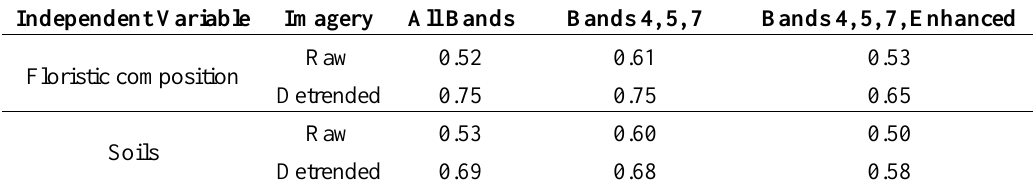
Table 3. Relationship between Landsat data, and either floristic or soils data, for Pastaza-Tigre sites. Values are the coefficient of determination (r 2 ) for linear regressions between the floristic gradient (measured by a single NMDS axis) or the soil cation gradient (measured by the log-transformed sum of the concentrations of Ca, Mg, Na, and K) as independent variables, and the first principal component of the indicated bands as dependent variables, for either unprocessed (“Raw”) or detrended (“Detrended”) imagery. “Enhanced” indicates use of the contrast adjustments and spatial convolution indicated in Section 2.3. All r 2 values are significant at P <